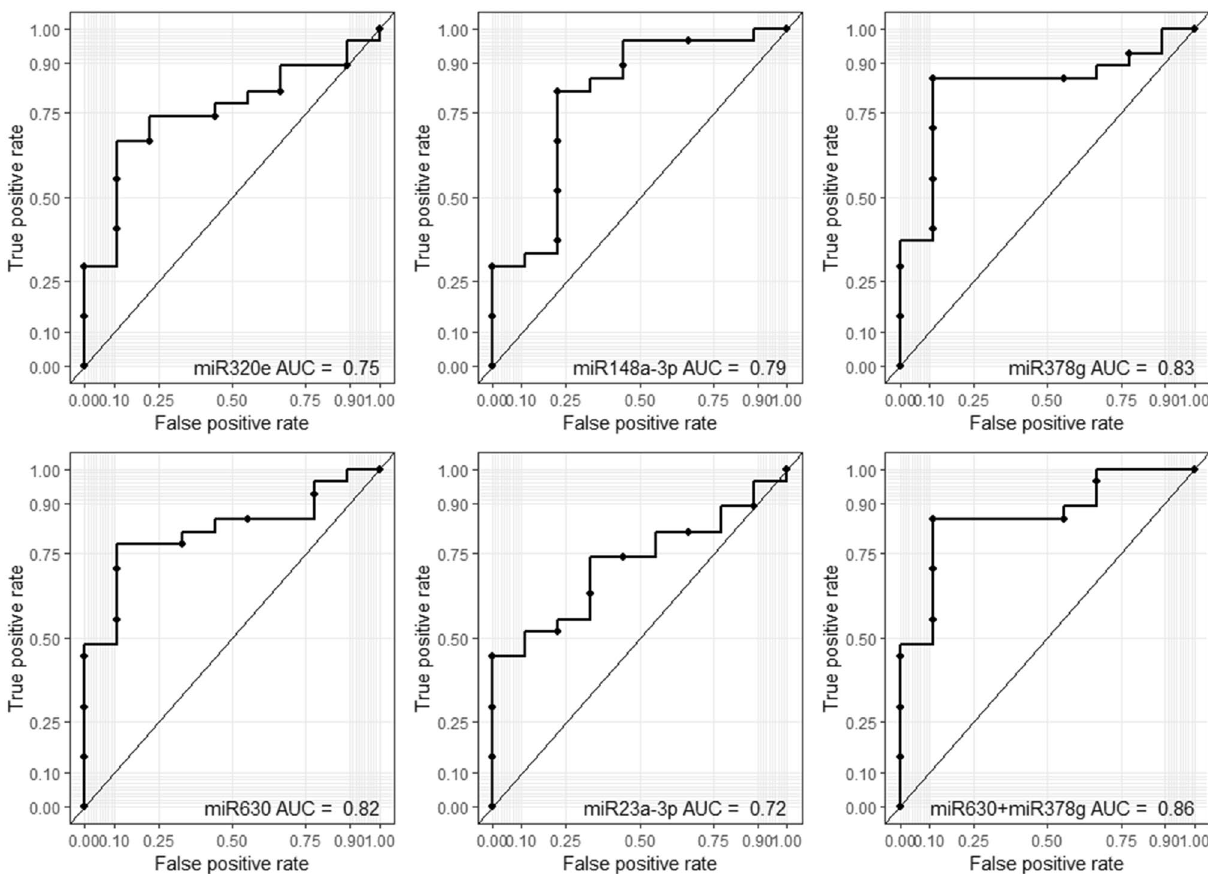
Figure 7. ROC curve analysis of human milk exosome miRNAs. ROC curves for the individual top five (miRNA-320e, miRNA-148a-3p; miRNA-378g, miRNA-630 and miRNA-23a-3p) or combined miRNAs (miRNA-630 and miRNA-378g) for discriminating HIV-1 infected women from healthy controls. ROC receiver operating characteristic, AUC area under the ROC